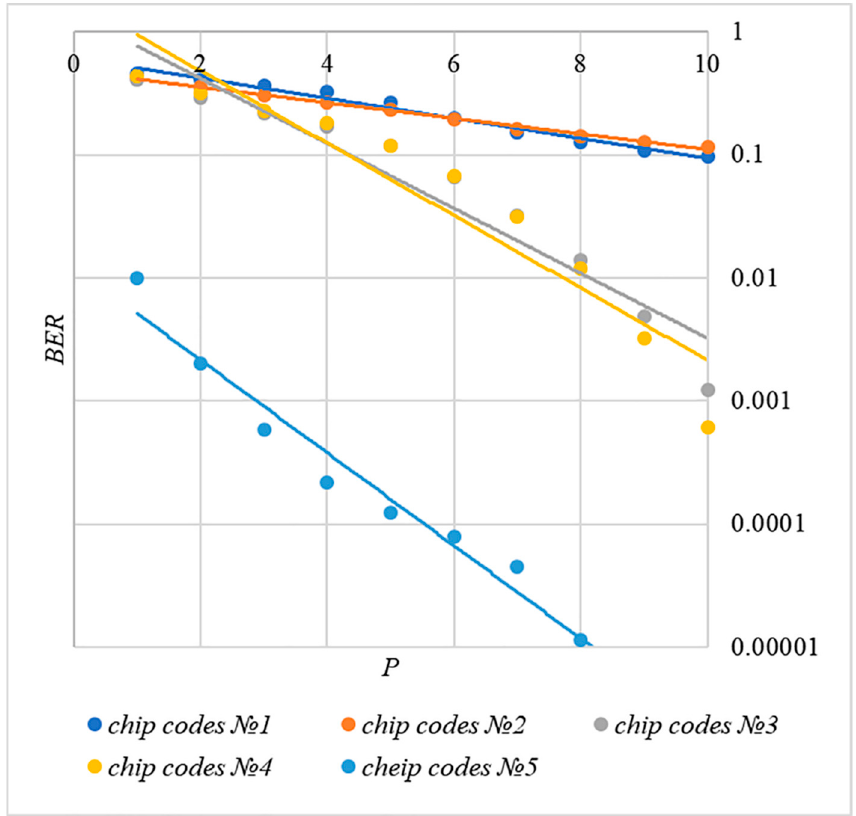
= . Figure 7. BER ( P ) dependencies for different rules for generating chip codes, k =